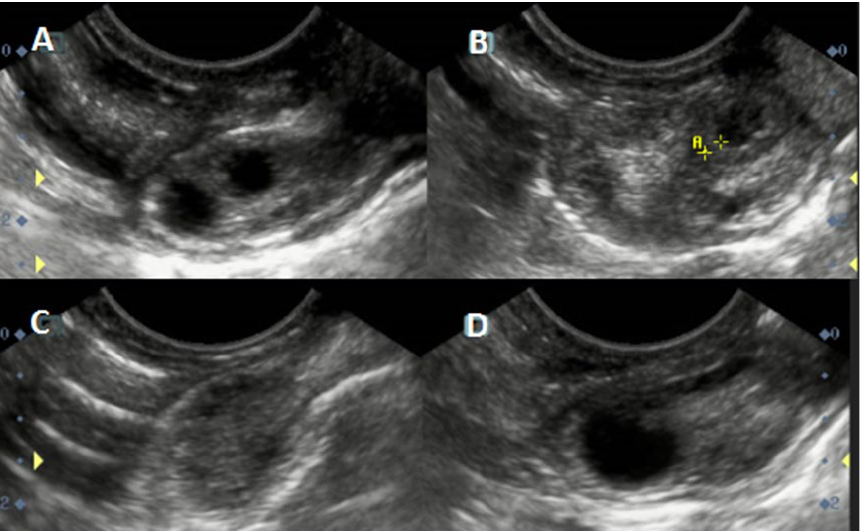
Figure 1. Ultrasonographic images (single dominant follicle vs. codominance). Llama 1 (codomi- nance example within the same animal): ( A ) presence of follicular codominance in the right ovary and ( B ) presence of follicles (<2 mm, see yellow A**) in the left ovary. Llama 2 (single dominant follicle example within the same animal): ( C ) presence of follicles (<2 mm) in the right ovary